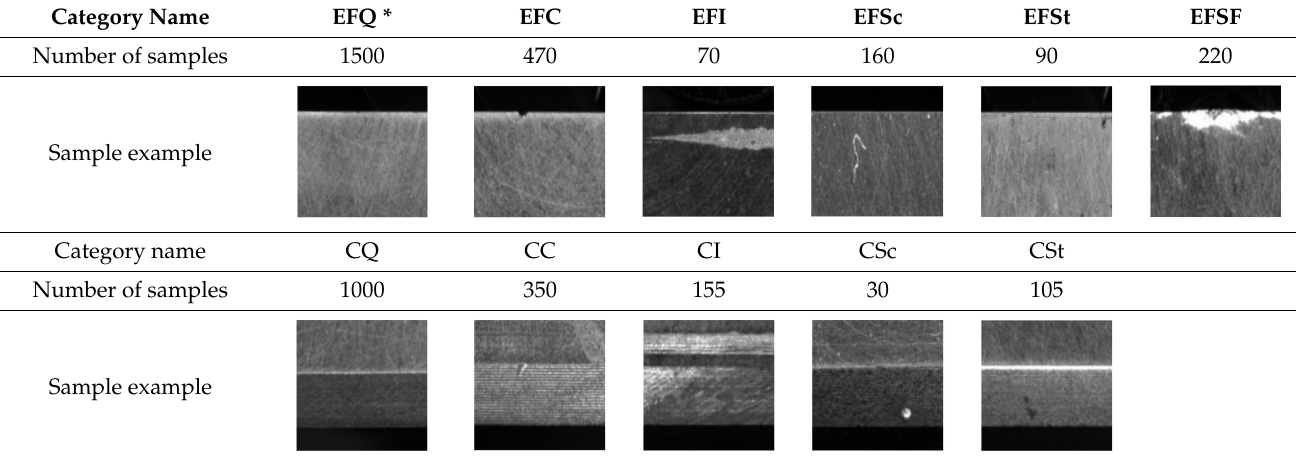
Figure 6. Samples of magnetic tile data set. Table 3. The sample examples and numbers of each category in the roller surface defect data